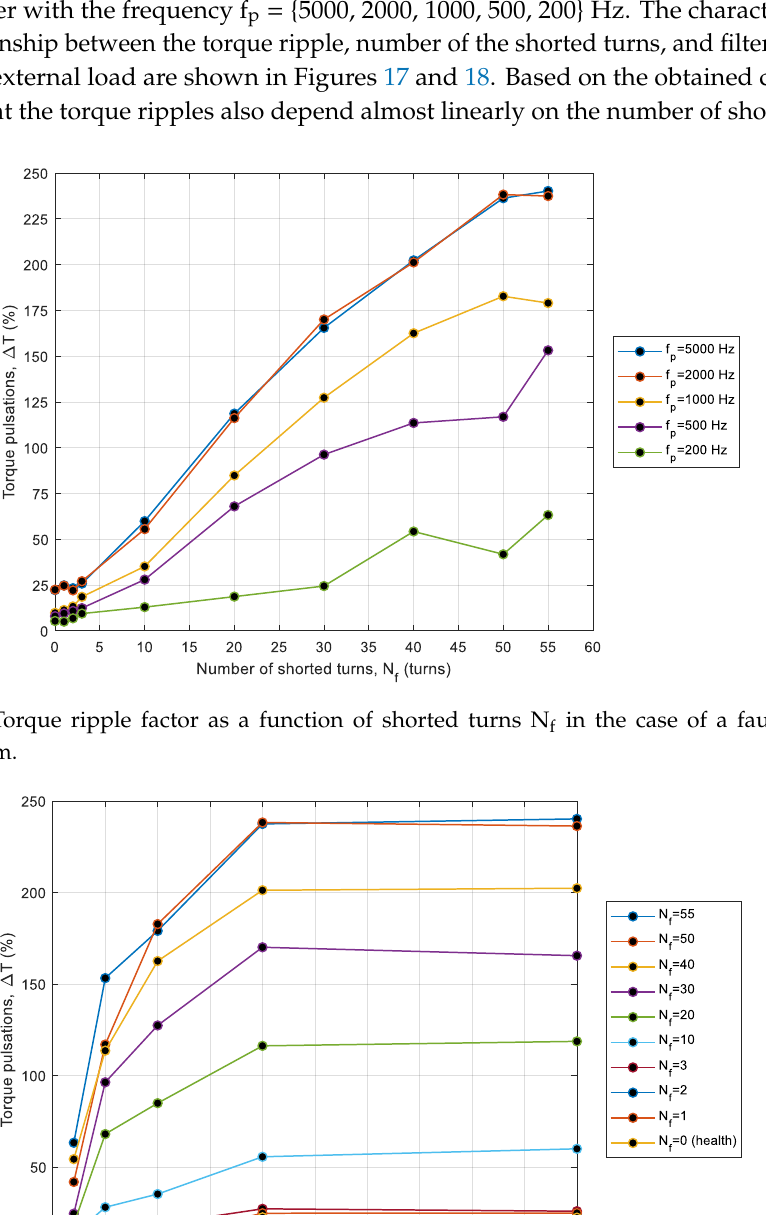
Figure 16. Torque ripple factor as a function of low-pass filter frequency fp in the case of a faulty motor, at T L = 0 Nm.